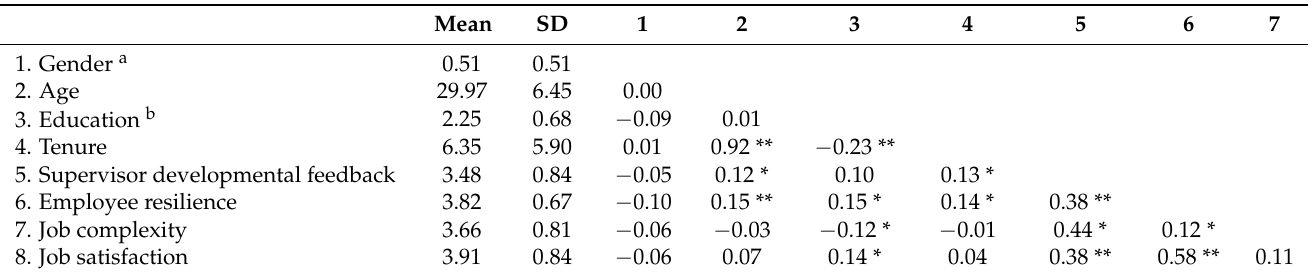
Table 3. Descriptive statistics, correlations of